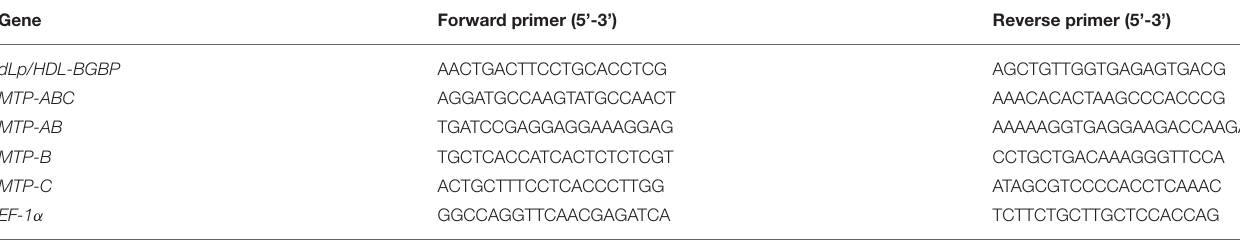
TABLE 3 | Primers used for qPCR in the present study. Gene Forward primer